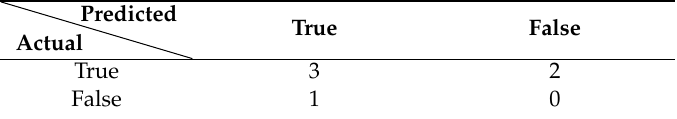
Table 7. The results of pothole classification in a complex environment.